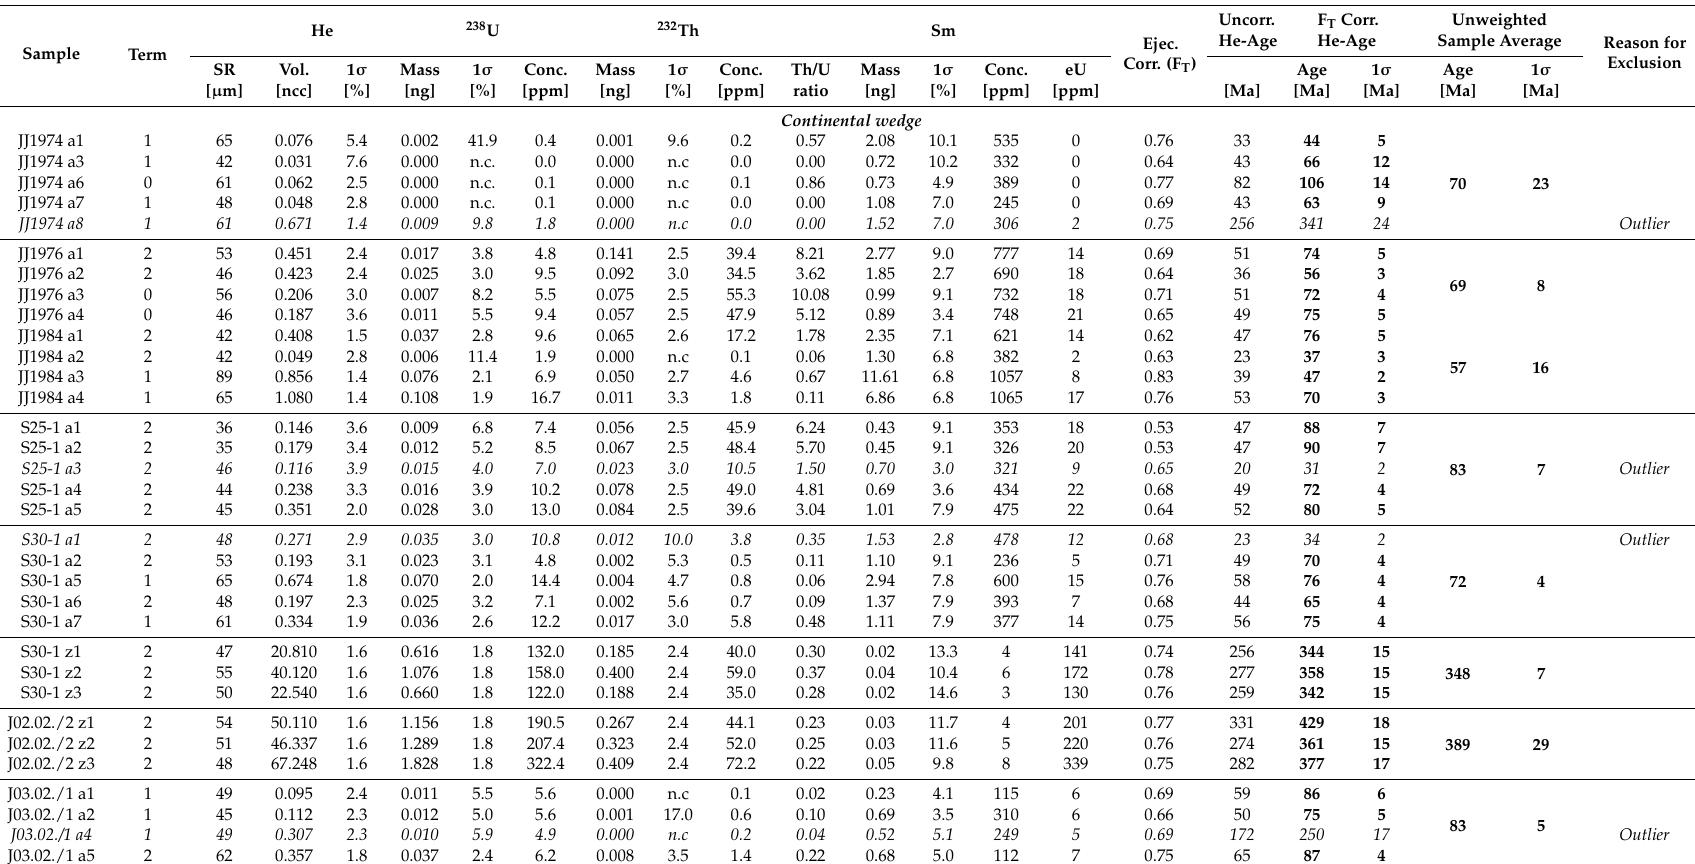
Table footnote: Term: Number of crystal terminations. SR: Sphere radius. Amount of helium is given in nano-cubic-cm at standard temperature and pressure. Amounts of radioactive elements are given in nanograms. Ejection correction (F T ): correction factor for alpha-ejection (according to Farley et al. [84] and Hourigan et al. [85]). Uncertainties of helium and the radioactive element contents are given as 1 σ in relative error %. When radioactive element concentrations were close to, or below, the detection limit, uncertainties were not calculated (n.c.). Uncertainty of the single-grain age is given as 1 σ in Ma and it includes both the analytical uncertainty and the estimated uncertainty of the F T . Uncertainty of the sample average age is 1 σ in